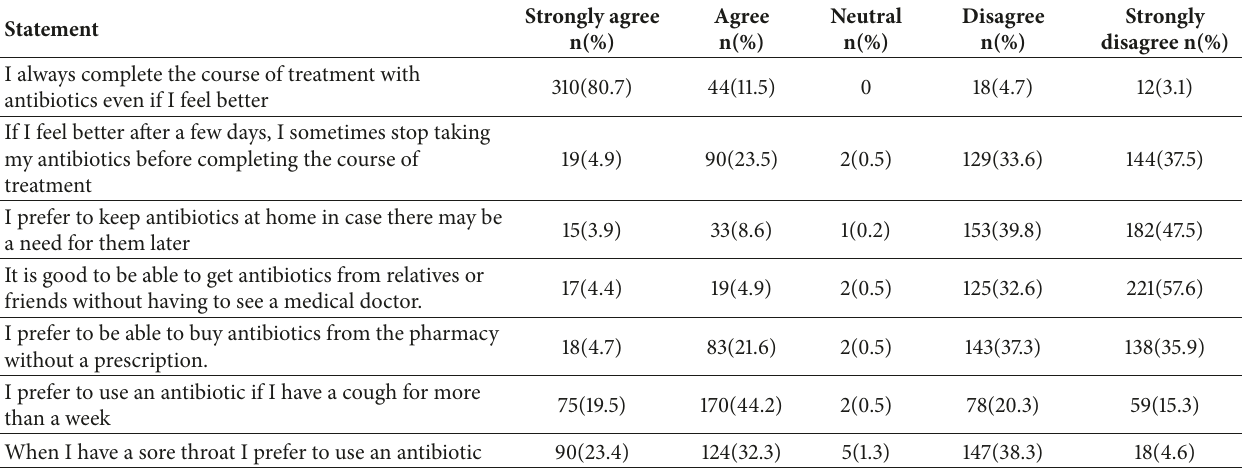
Table 3: Attitudes towards use of antibiotics among Harar city and its surrounding residents from February 1 to May 1, 2017 (n =